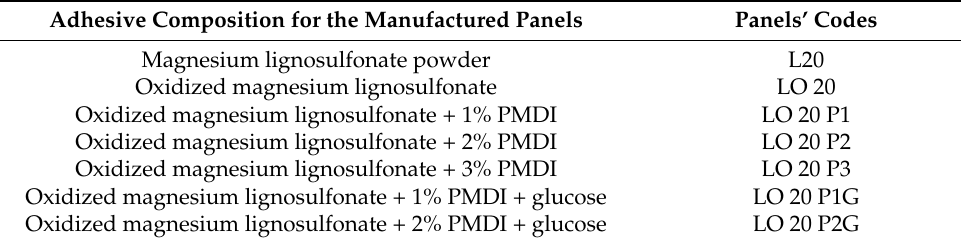
Table 4. Composition of the adhesives and the panels’ identification